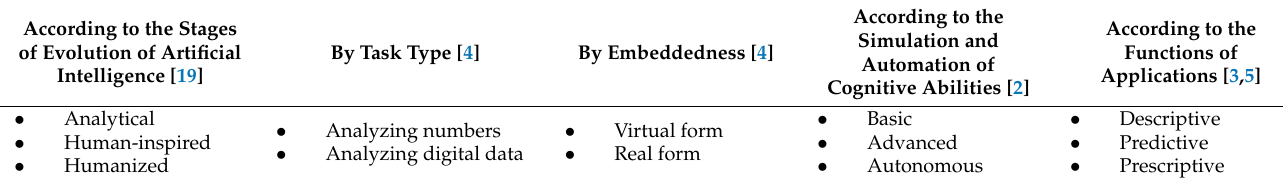
Table 1. Classifications of artificial